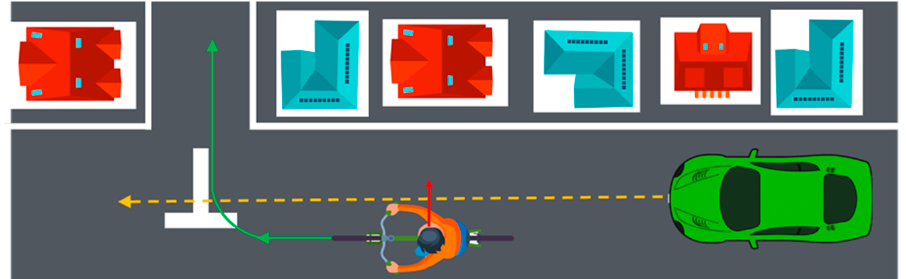
Figure 11. Demonstration of a scenario where a cyclist is turning his or her head before crossing the